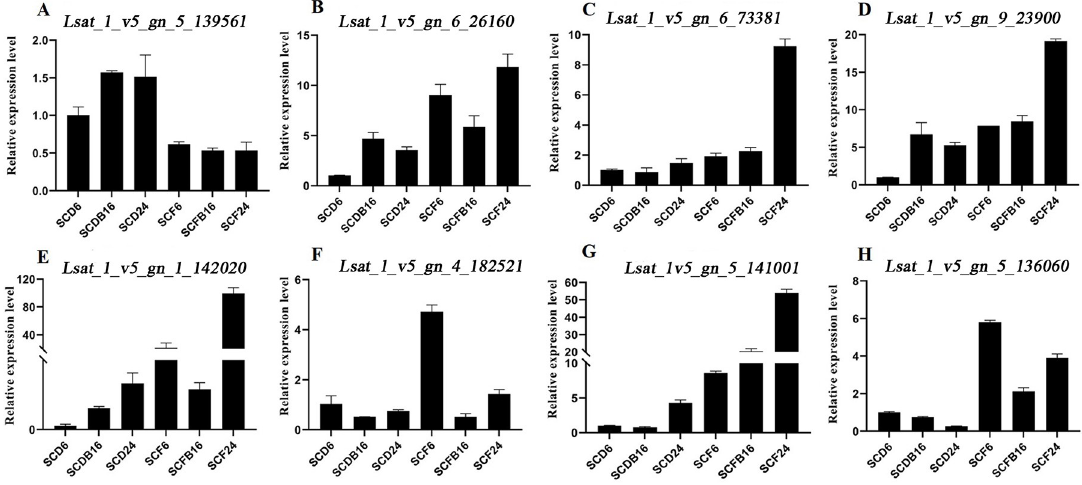
Fig 3. qRT-PCR validation of DGEs results based on gene expression